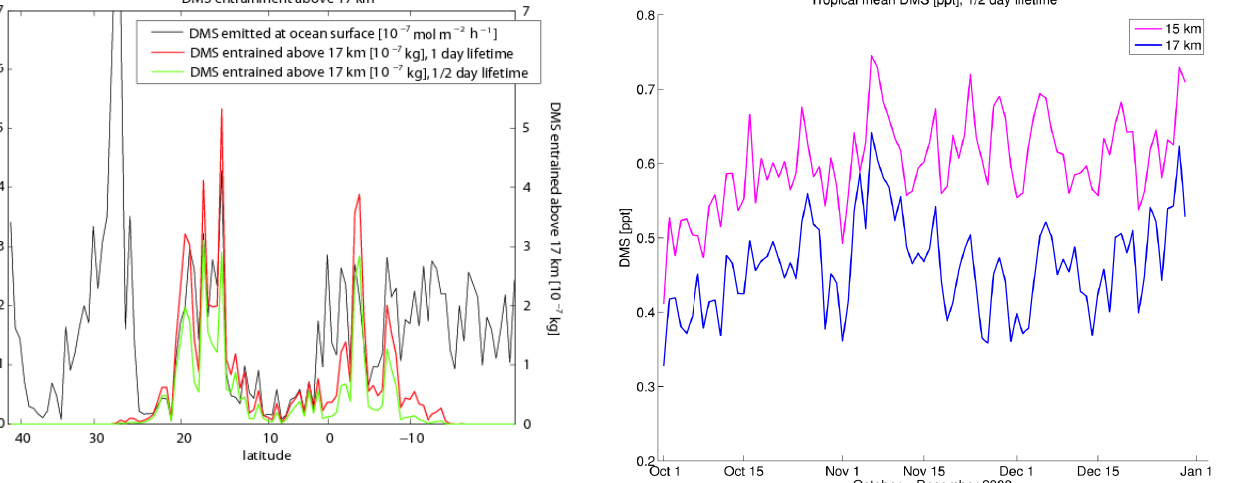
Fig. 7. Time series of tropical (20 ◦ S–20 ◦ N) mean DMS volume mixing ratios at 17km and 15km for October to December 2009. The time series is based on FLEXPART model simulations using TransBrom average emissions for the tropical oceans and 1 / 2-day atmospheric lifetime for